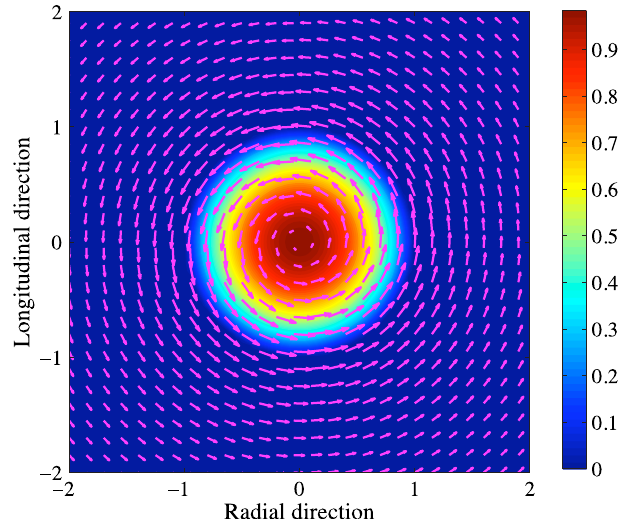
(cid:2) (cid:3) (cid:1) e 0 z (magenta arrows) for a cylin-